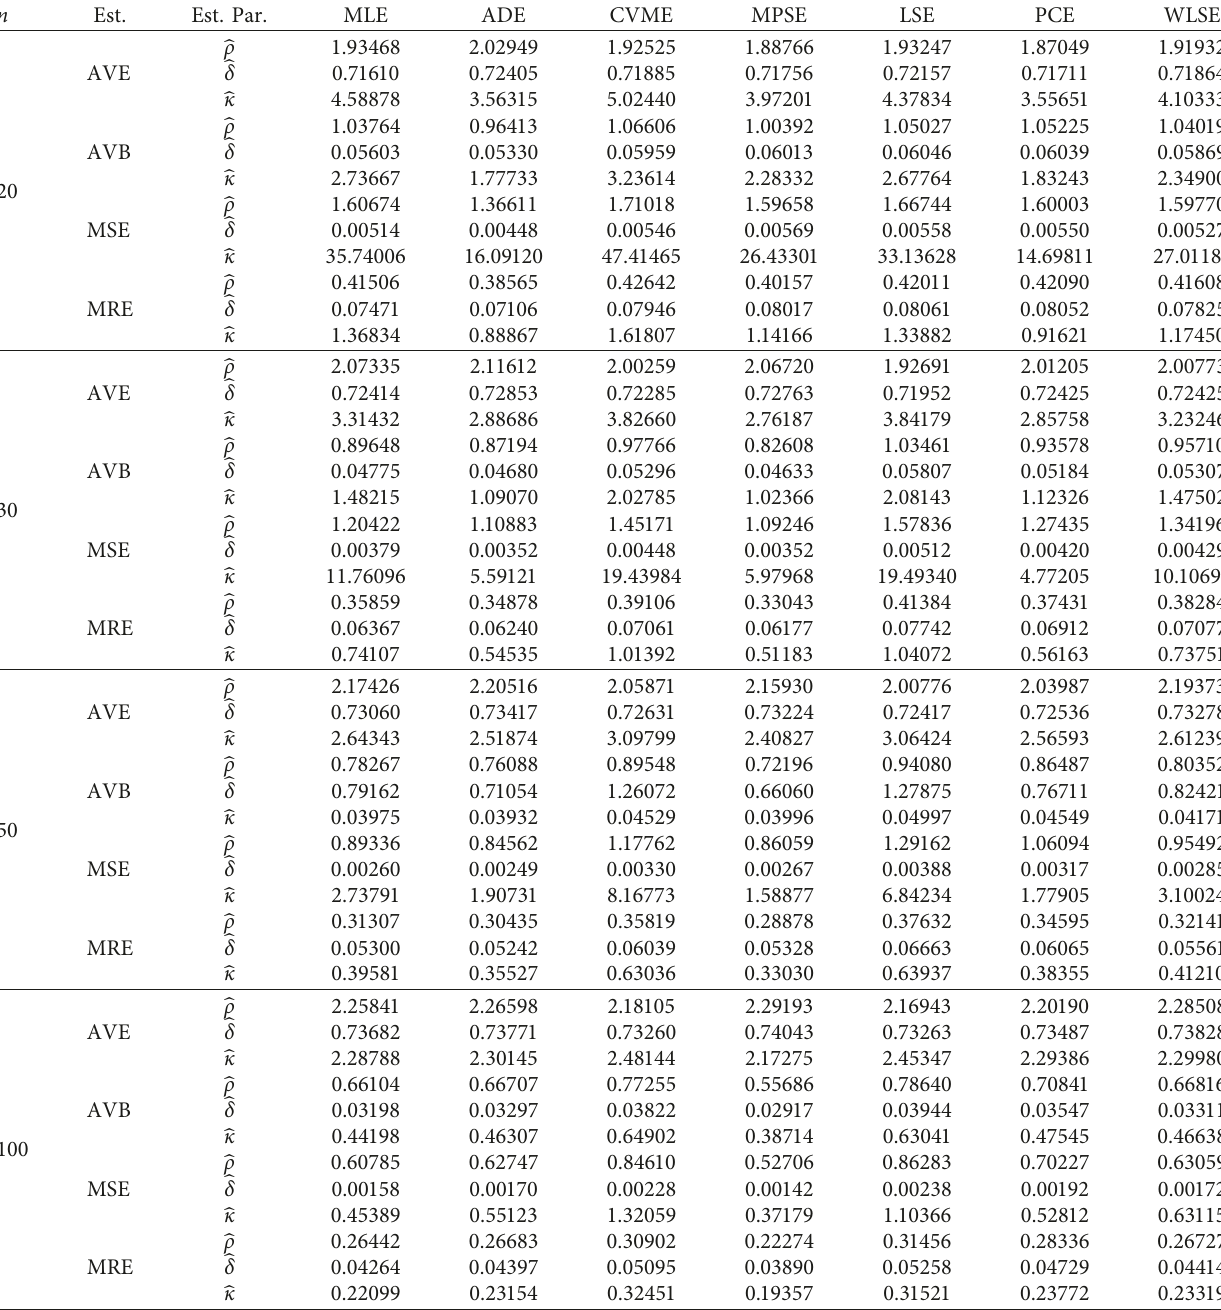
Table 7: Simulation results of the AVE, AVB, MSE, and MRE of BXLE distribution for ( ρ � 2 . 5 , δ � 0 . 75 , κ � 2 ) . n